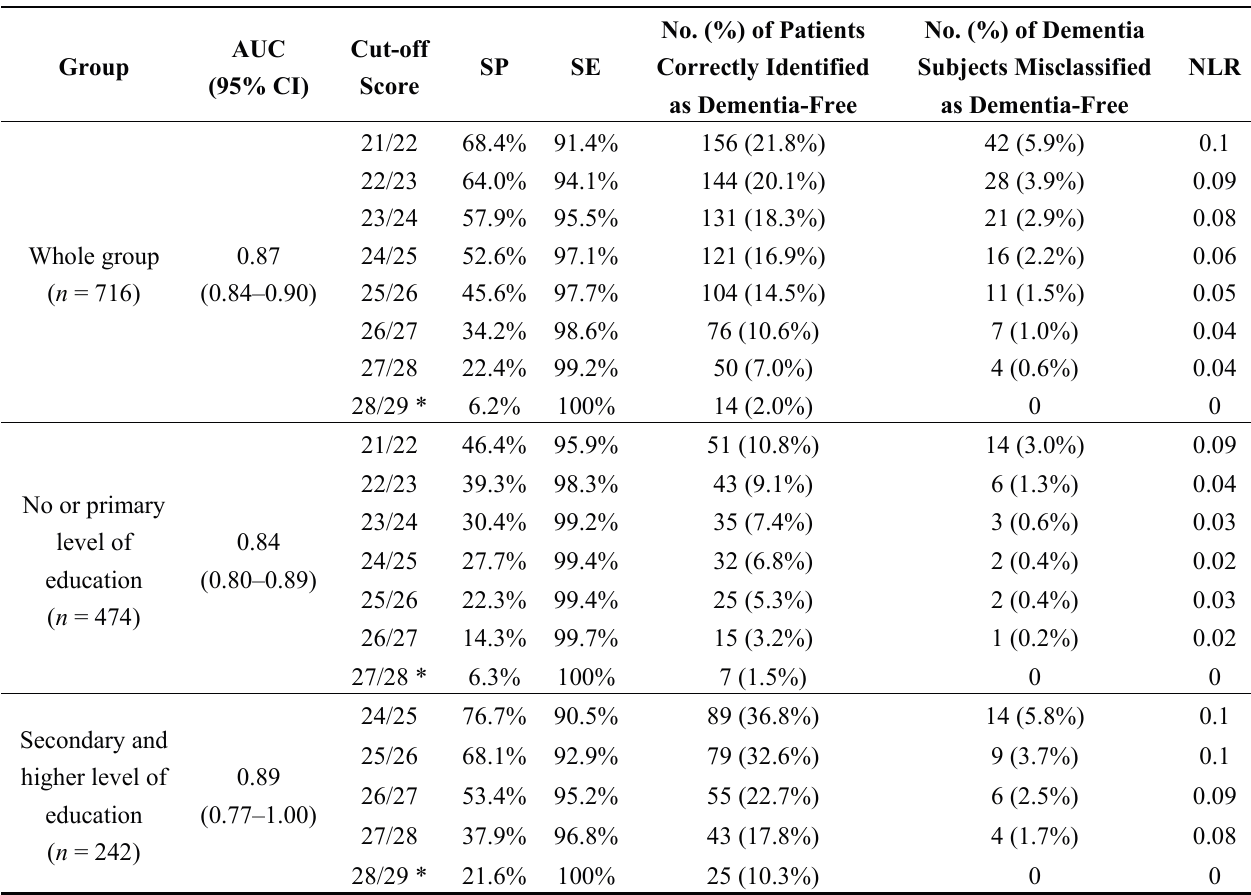
Table 3. AUCs, cut-off scores of the MMSE, SP, SE, number (%) of patients correctly identified as dementia-free, number (%) of dementia subjects misclassified as dementia-free and NLRs before and after education